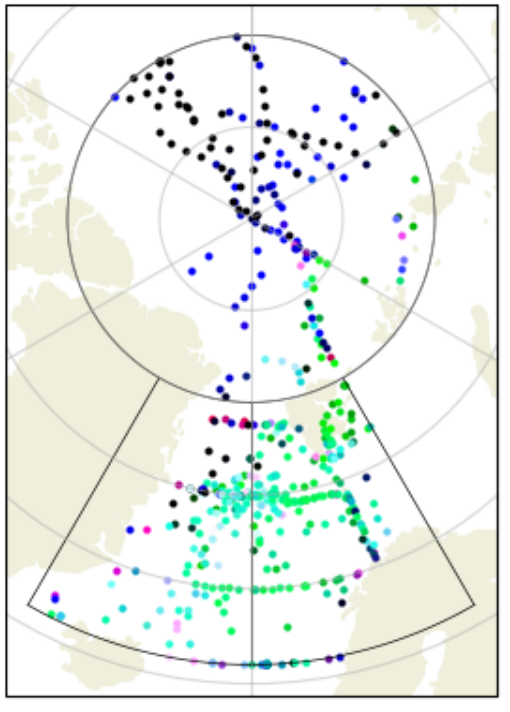
Figure 17. T14 regions 1 (West GIN Seas, bottom left), 2 (East GIN Seas, bottom right) and 3 (High Arctic, top) with correspond- ing MDB data. Each point is coloured according to the probability density of a Gaussian with mean equal to the T14 regression and standard deviation equal to its quoted RMSE, which is a measure of how consistent the data are with the T14 fit. The red component is the consistency with the region 1 fit, green with the region 2 fit and blue with the region 3 fit.